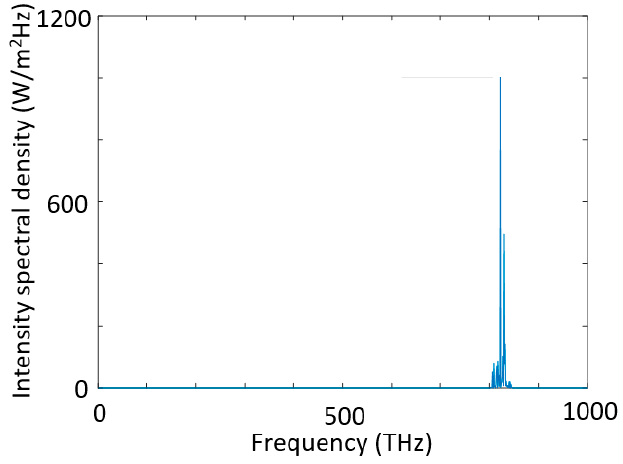
Figure 6. Intensity spectral density at the band-pass filter output for harmonic generation at 820 THz.